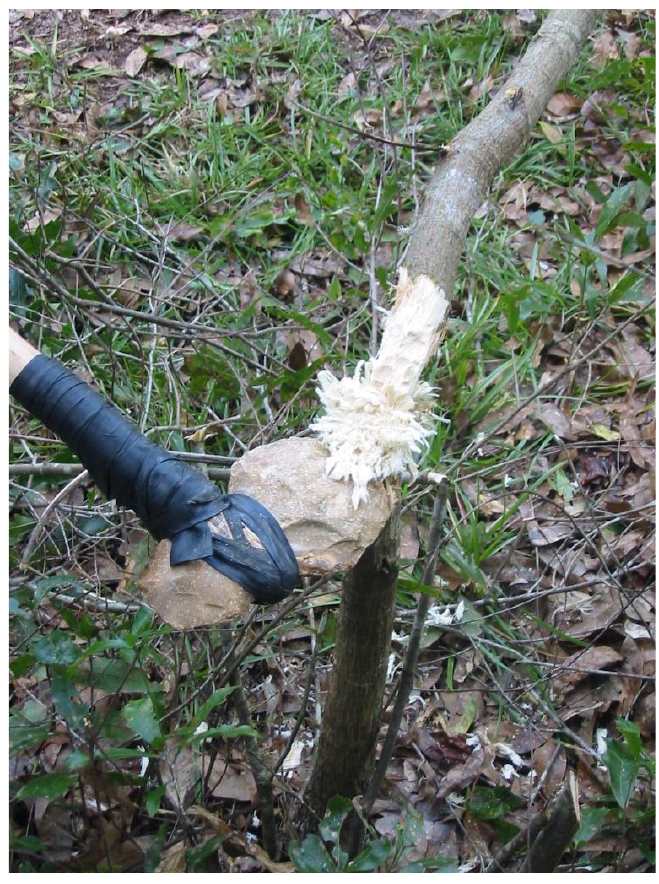
Figure 1. Quercus hemisphaerica (laurel oak) sapling felled with a stone axe hafted to a Ostrya virgin- iana handle with a bicycle inner tube showing the effects of a typical